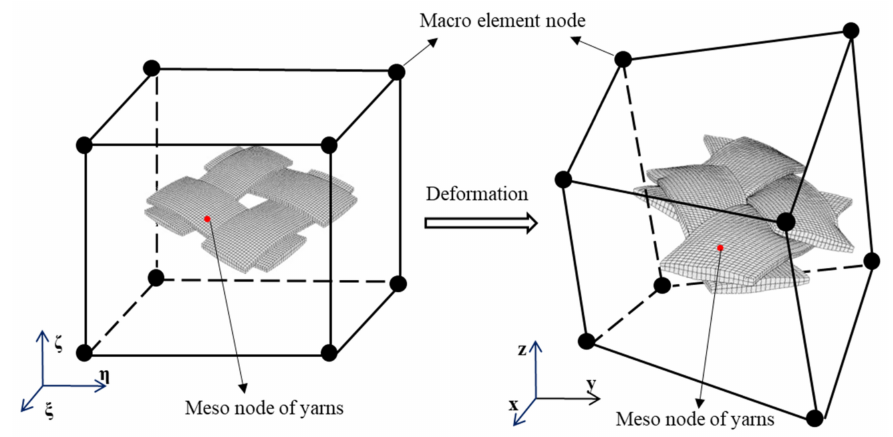
Figure 4. Meso node of yarns embedded in a macro element. Reference and real frames.